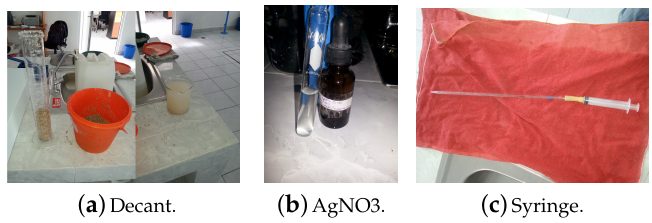
Figure A8. Decantation and absence of hydrochloric